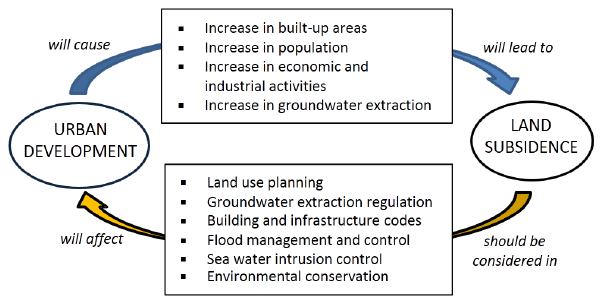
Figure 2. Urban development and land subsidence relation in Jakarta (Abidin et al., 2011).